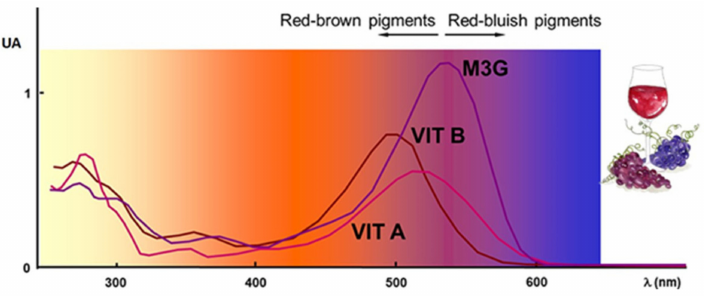
Figure 4. UV-visible spectra of malvidin-3- O -glucoside and vitisins A and B. Adapted from